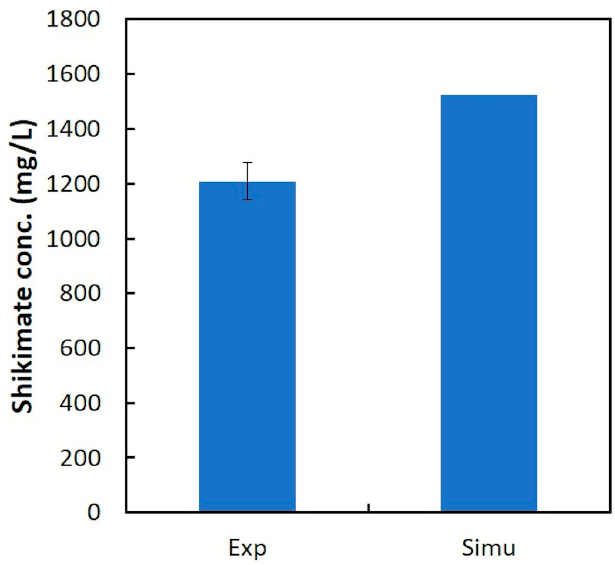
Figure 5. Comparison of shikimic acid concentration obtained by dFBA at 27 h to the experimental value.